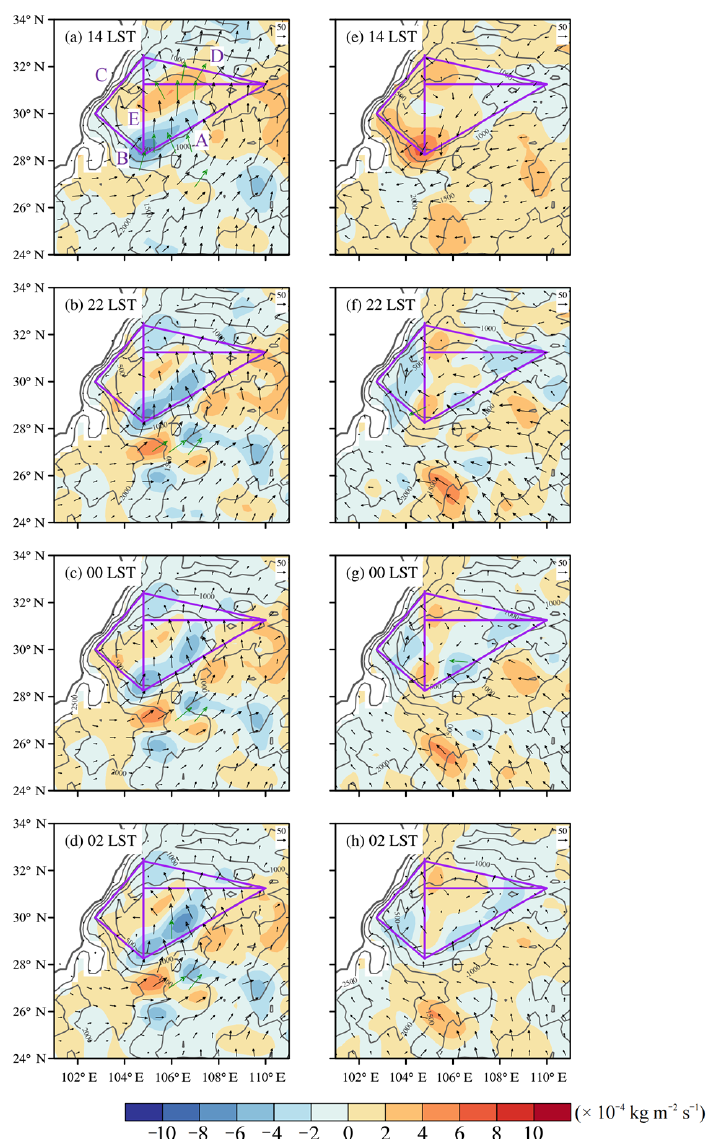
Figure 14. Diurnal variations of the moisture flux and the moisture flux divergence from surface— 700 hPa caused by ( a – d ) geostrophic creeping flows and ( e – h ) ageostrophic creeping flows. Purple lines in ( a ) represent boundaries A, B, C, D, and E.